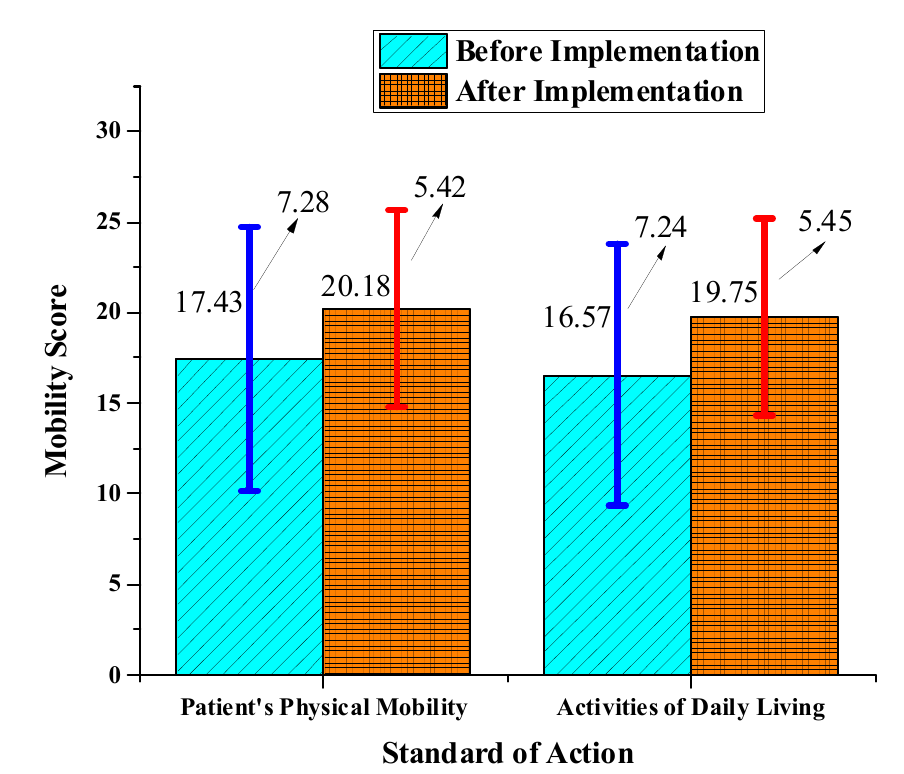
Figure 6. Comparison of daily activity scores of community patients with respiratory diseases before and after the implementation of the proposed community structure.